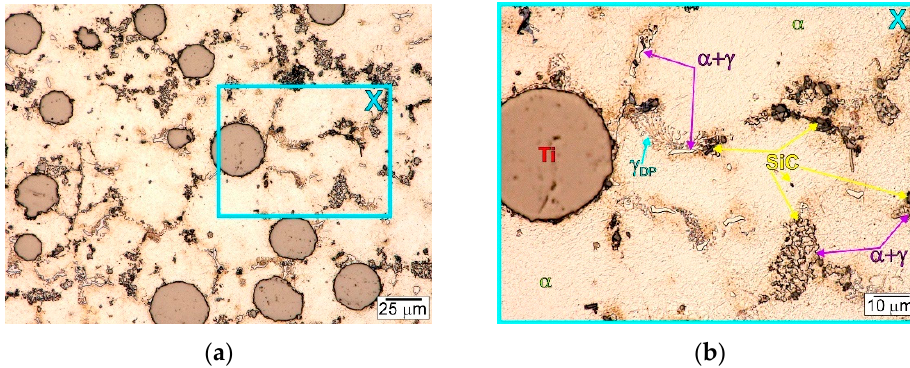
Figure 5. Microstructure of AZ91/(SiC + Ti) p hybrid composite: ( a ) Digital microscope micrographs of etched surface; ( b ) Higher magnification of area marked as X on ( a ) micrograph.